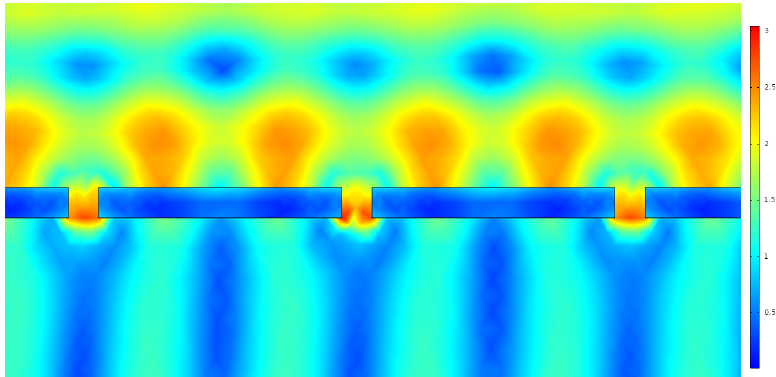
Figure 14. Local field amplification in the nanoantenna apertures.